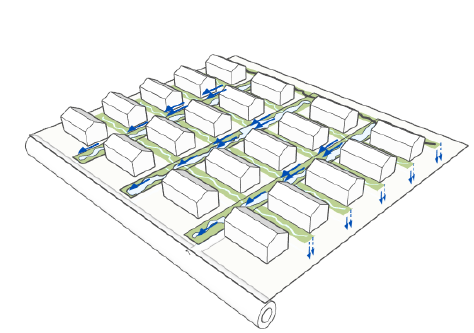
Figure 2. Sustainable Water Management